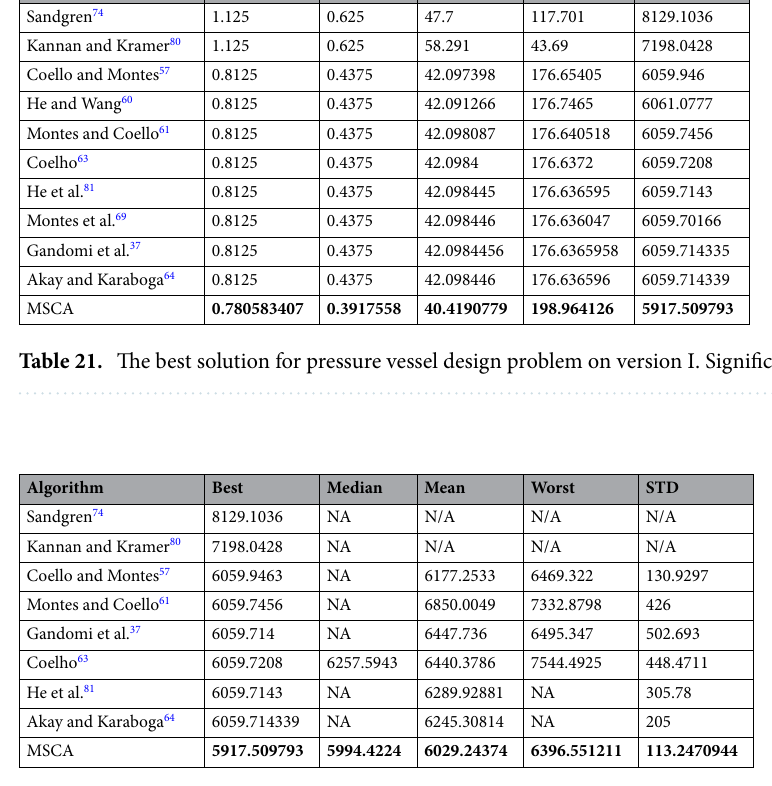
Table 22. Statistical result for pressure vessel design problem on version I. NA means not available. Significant values are in bold.